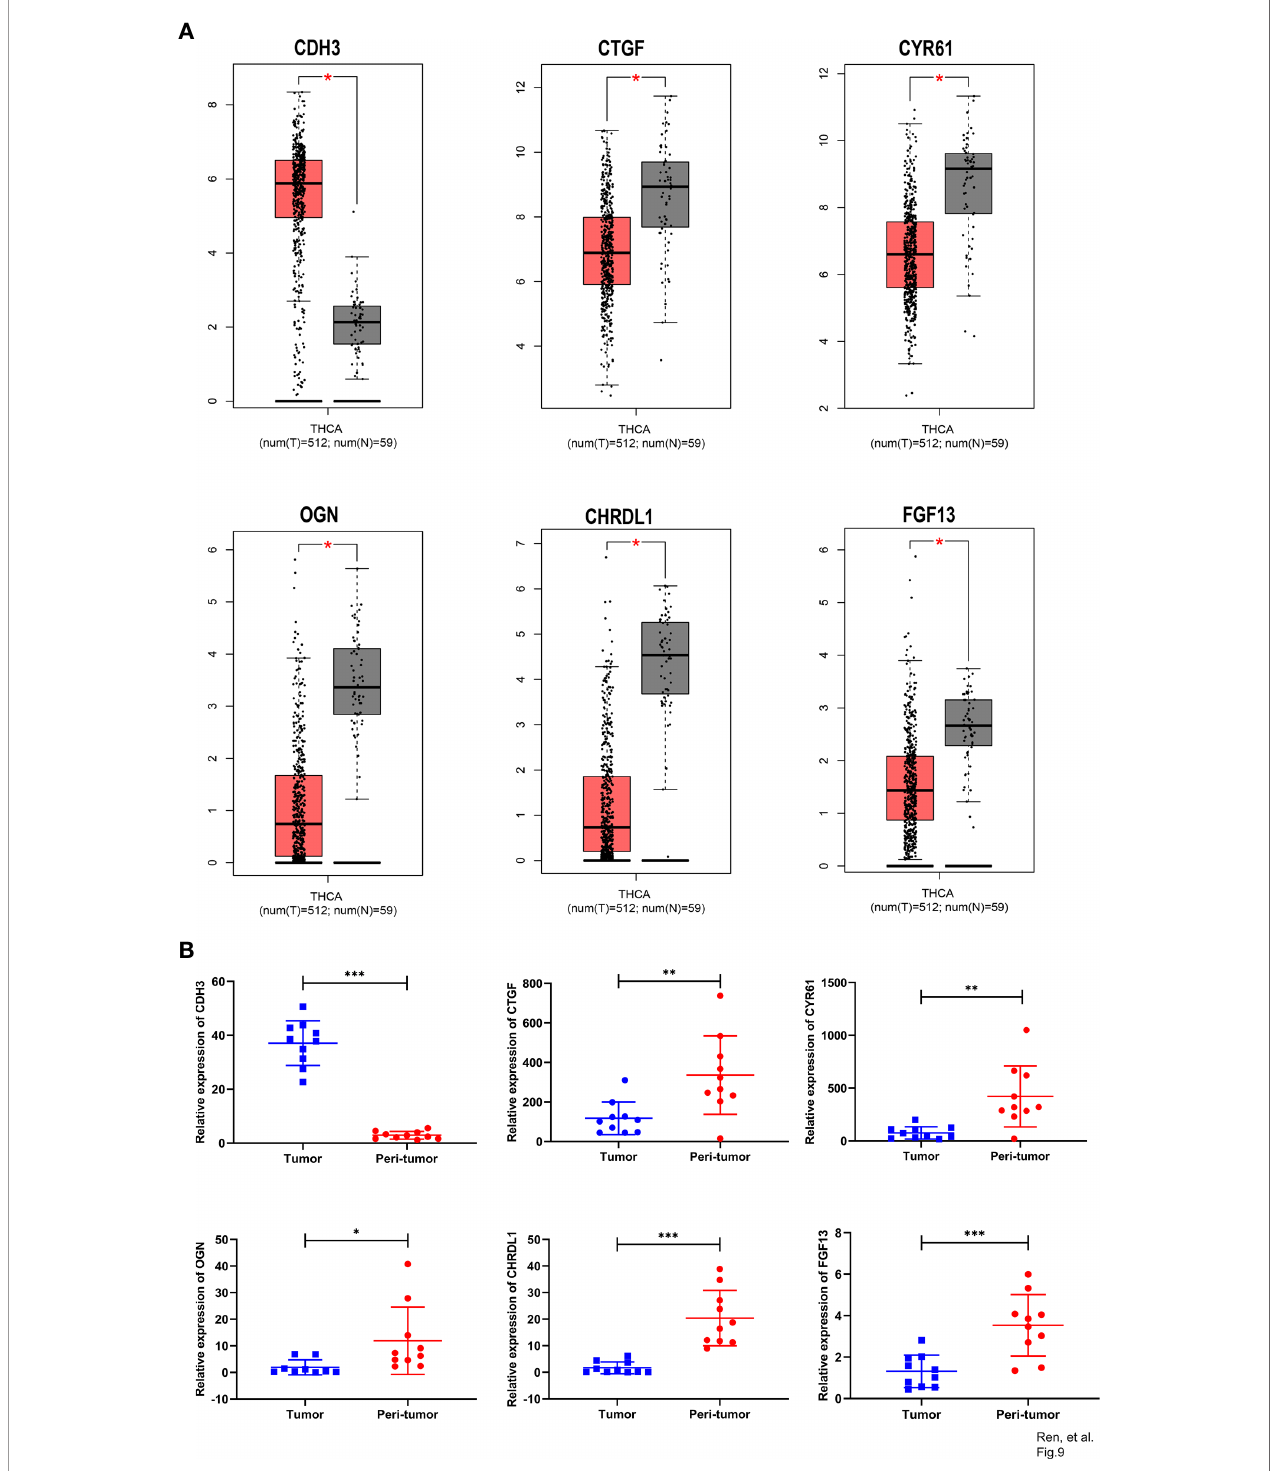
FIGURE 9 | Comparison of expression of six hub genes between tumor and peri-tumor. (A) Box plots of CDH3, CTGF, CYR61, OGN , CHRDL1 and FGF13 expression in THCA tumor and peri-tumor tissues. (B) Scatter plots of CDH3, CTGF, CYR61, OGN , CHRDL1 and FGF13 were constructed using transcriptome sequence data of our own patients ’ cohort. (*p<0.05; **p<0.01;